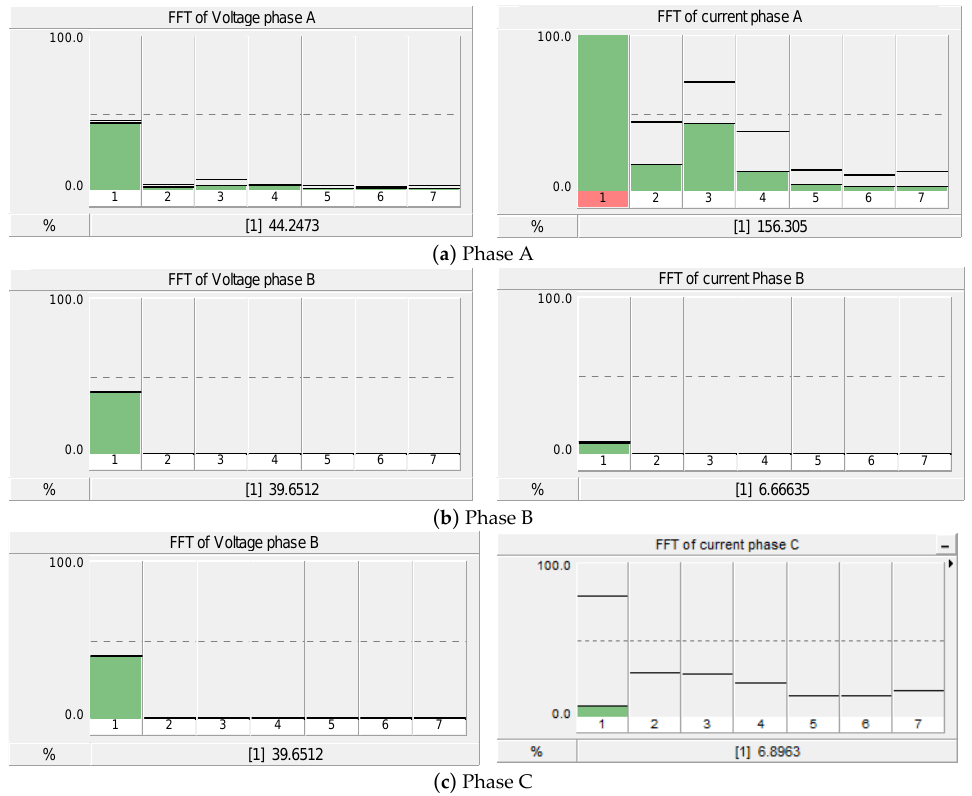
Figure 19. The voltage and current at the LV side (0.4 kV) transformer 500 kVA when the BRKC open circuit is at 0.4 s.